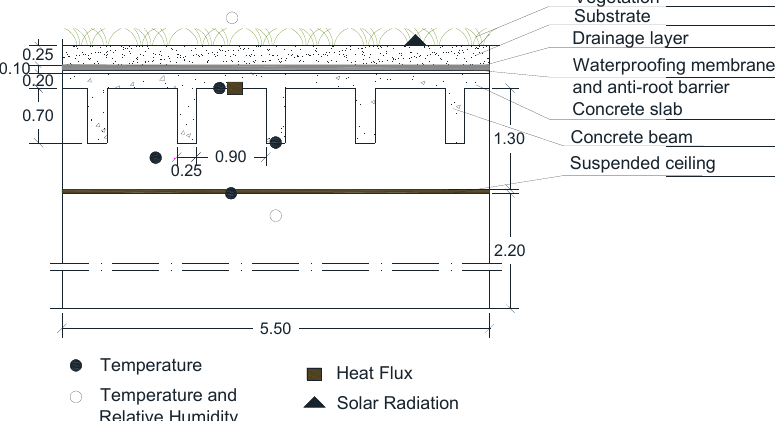
Figure 3. Measurement setup of the technical sound room in the Calouste Gulbenkian Foundation.